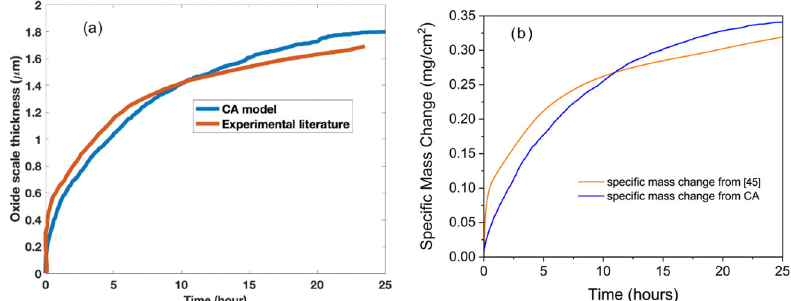
Fig. 3 Validation of oxidation kinetics with experimental literature. a The scale for the CA model is established by direct comparison with experimental results at 1050 °C. b The speci fi c mass change obtained from the CA model is compared against the experimental literature 45